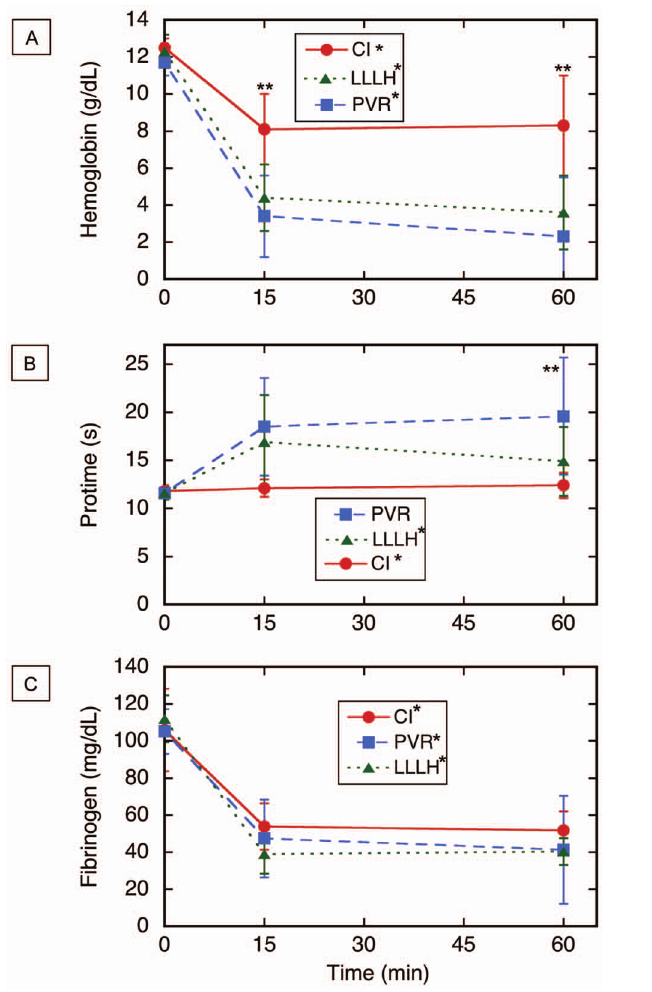
Figure 5. Hematologic testing for three porcine models of noncompressible truncal hemorrhage. (A) Serum hemoglobin. (B) Protime. (C) Serum fibrinogen. Time zero=moment of injury; CLI=- central liver injury (N=6); PVR=portal vein resection (N=6); LLLH=he- patic left lower lobe hemitransection (N=10). Values shown are mean 6 sd; *p , 0.05, Kruskal–Wallis one-way analysis of variance on all three time points for a given injury; **p , 0.05, Kruskal–Wallis one-way analysis of variance on all three injuries at the indicated time point. Also refer to Table S2 in file S2.